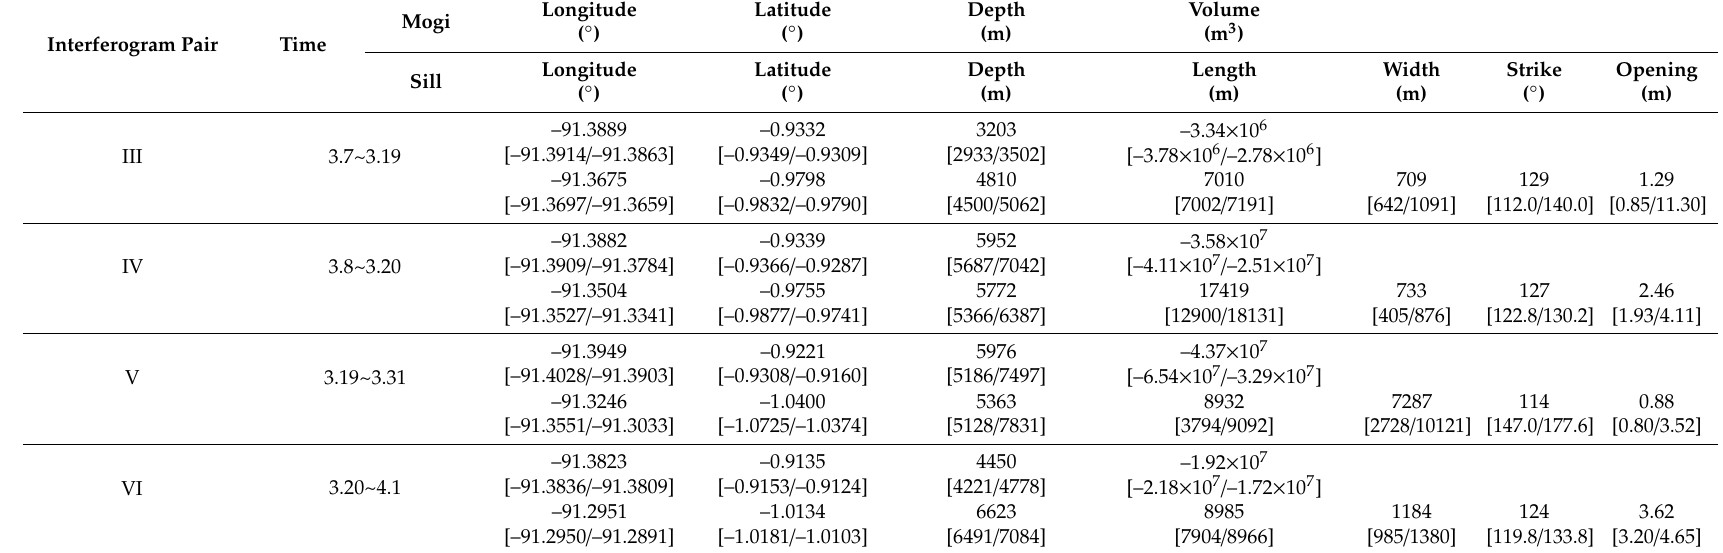
Table 2. Parameters of joint deformation source models for interferograms